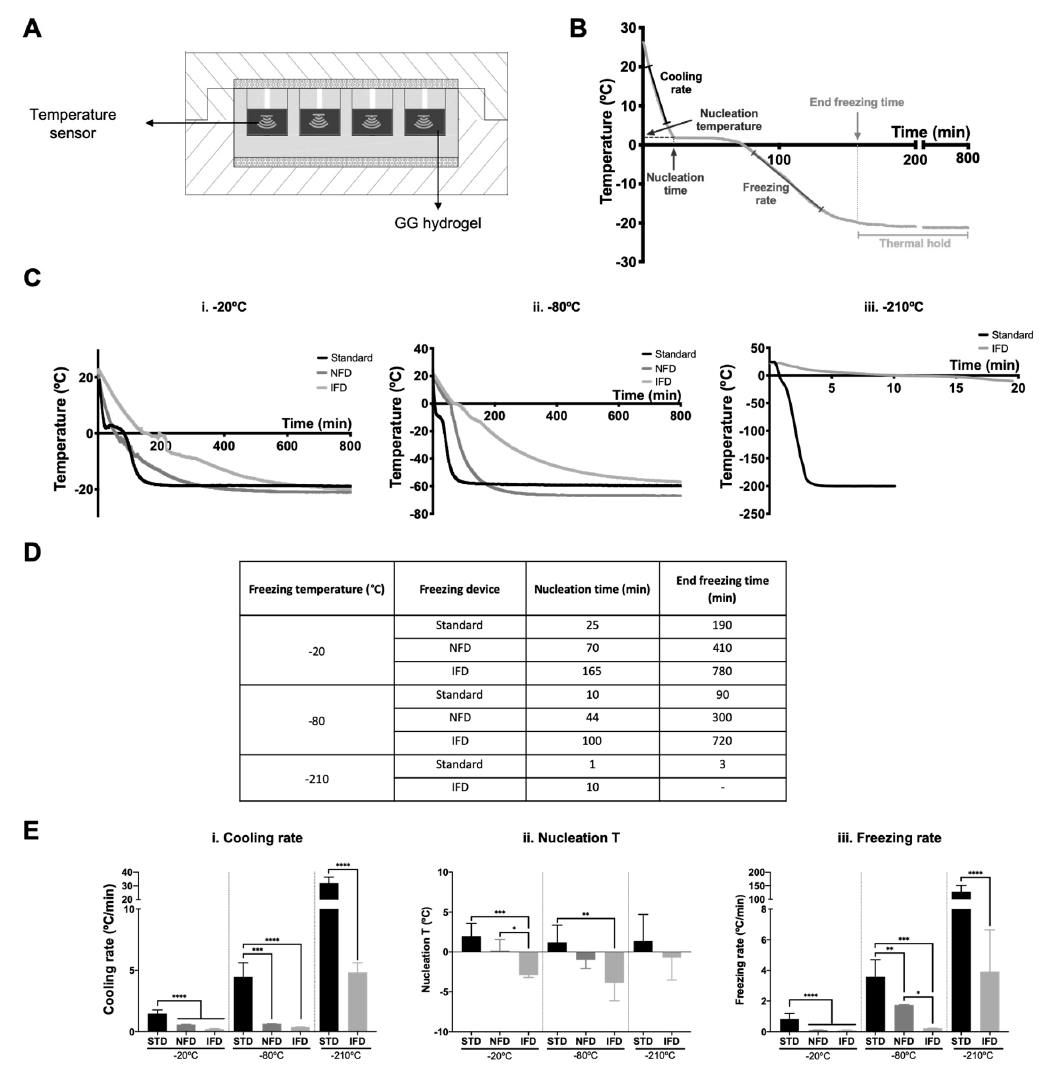
Figure 2. Freezing profiles of 1.25% gellan gum (GG) hydrogels. ( A ) Cross-section of the insulated freezing device with GG hydrogels. The temperature curves were measured using a temperature sensor that was placed inside the hydrogel. ( B ) Schematic of a thermal profile of a GG hydrogel with the cooling, nucleation temperature (T) and time, freezing rate, and end freezing time marked. ( C )